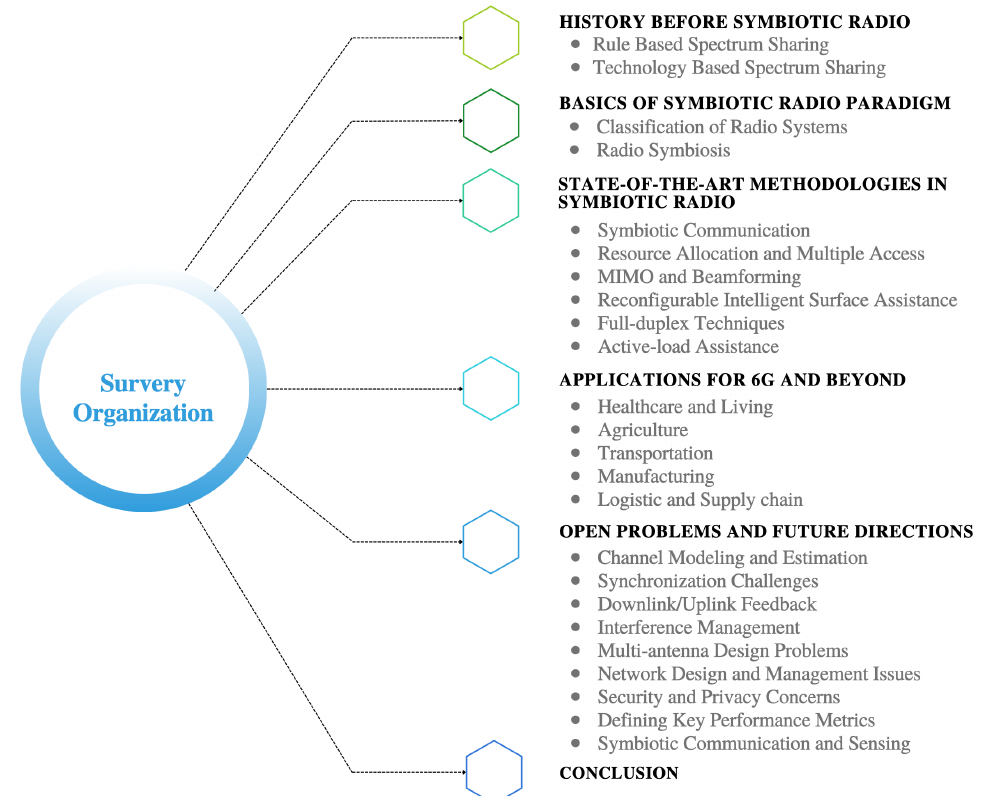
Figure 1. The organization of the sections in this